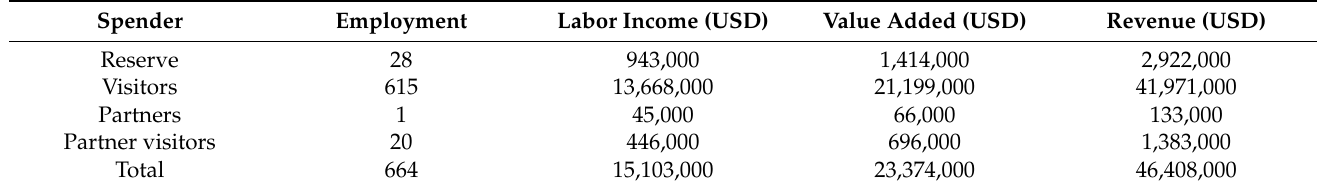
Table 11. Estimated annual contributions to employment, labor income, value added, and revenue by Apalachicola Reserve.